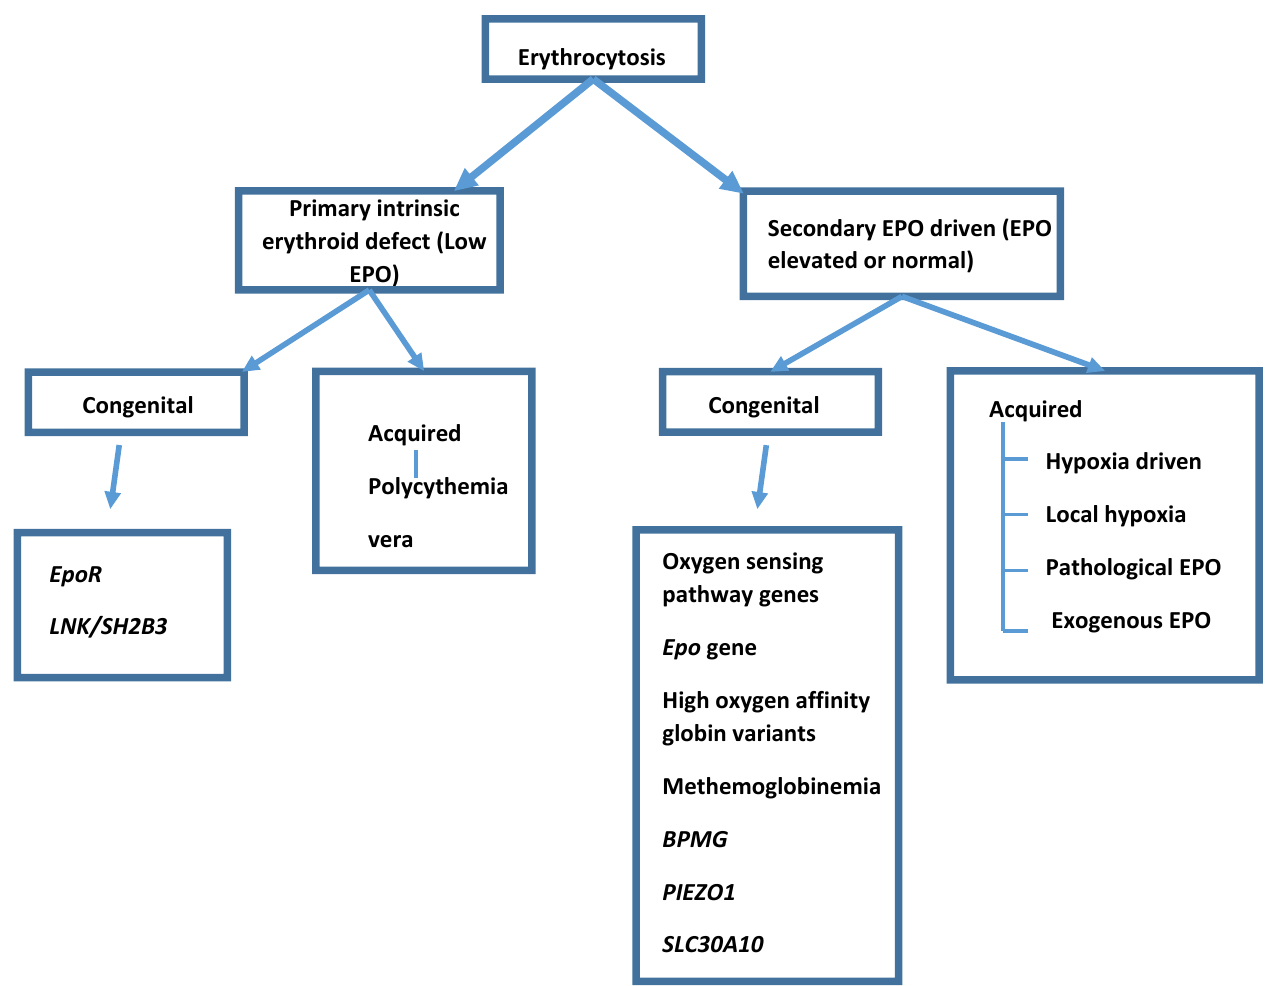
Figure 1. Classification of